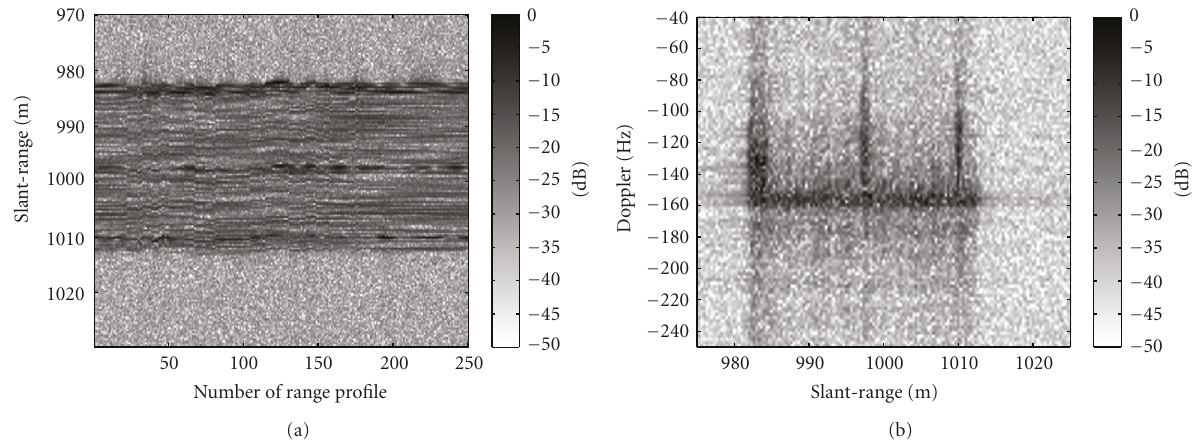
Figure 12: (a) Range profiles and (b) ISAR image without using reference profiles. The results correspond to the simulated data presented in Figure 5.